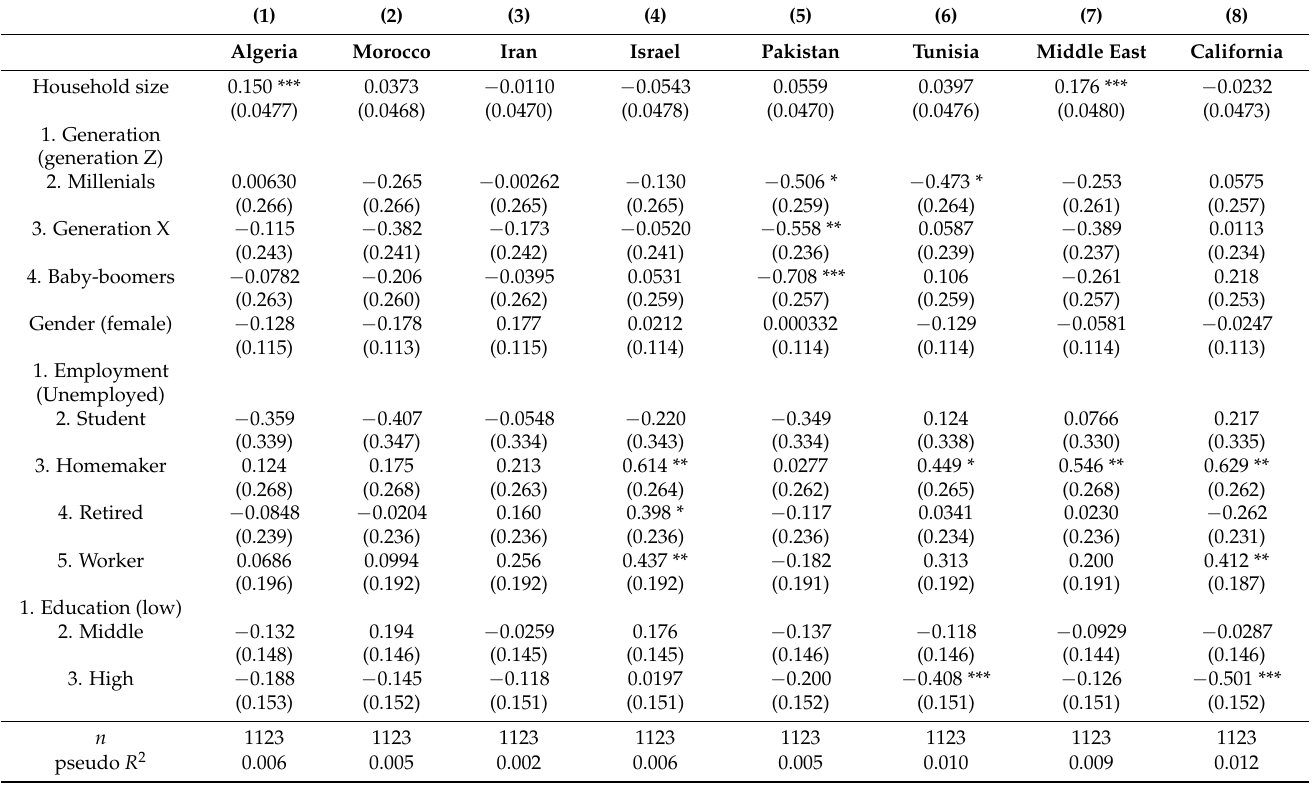
Table A2. Ordered logit model estimates for the for the date fruits quality according to the